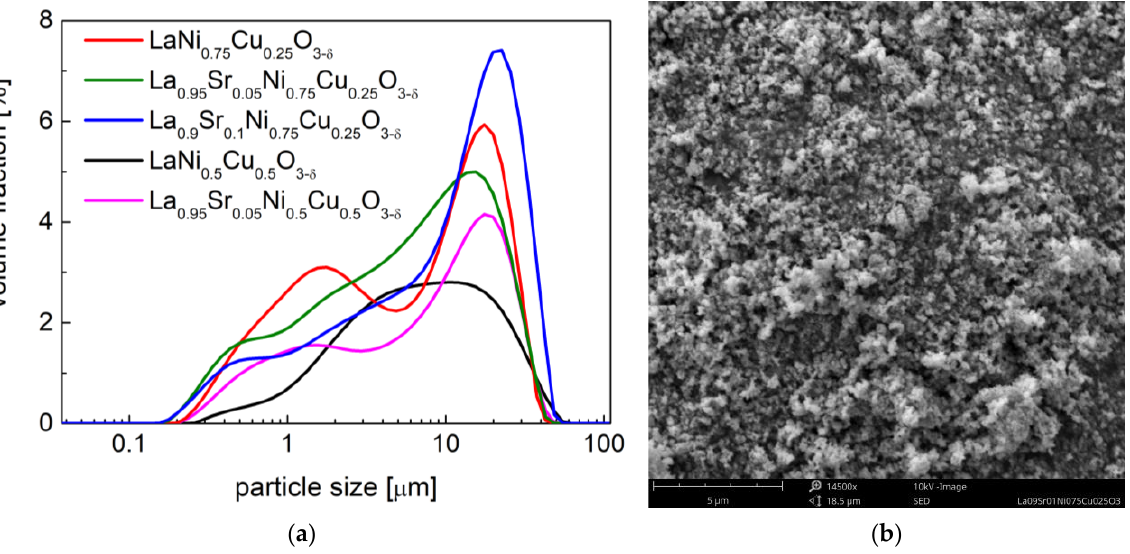
Figure 3. ( a ) Particle size analysis results of La 1−x Sr x Ni 1−y Cu y O 3−δ powders; ( b ) exemplary scanning electron micrograph of La 0.9 Sr 0.1 Ni 0.75 Cu 0.25 O 3−δ perovskite. ning electron micrograph of La 0.9 Sr 0.1 Ni 0.75 Cu 0.25 O 3 − δ